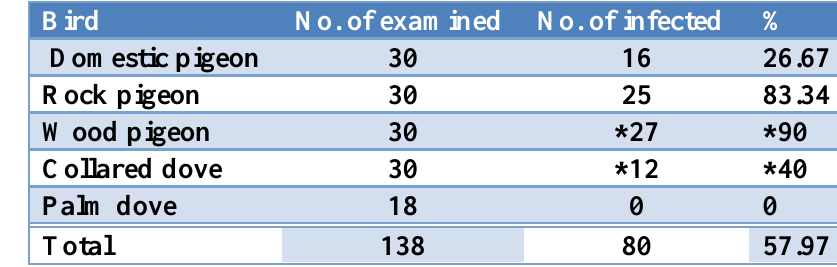
Table, 4: The infection rates with cestodes in different columbides.